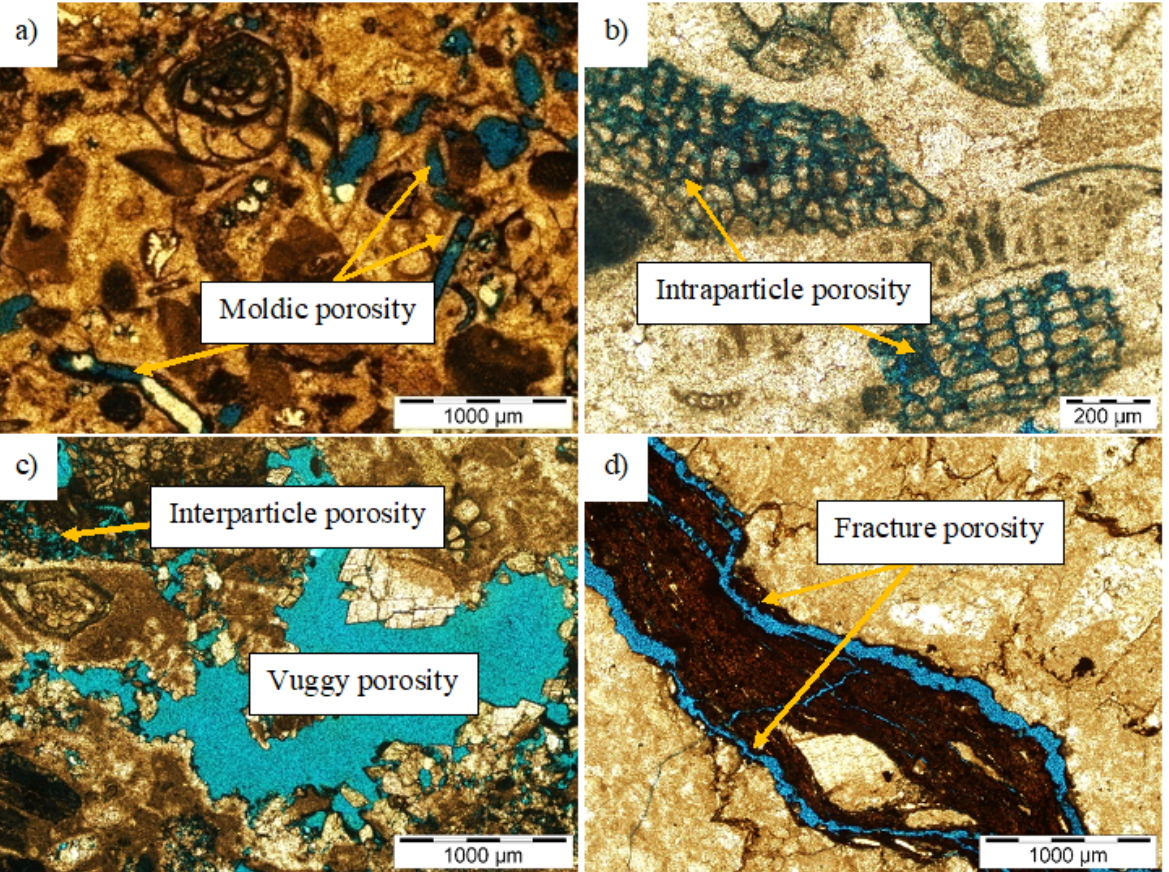
Figure 9. Photograph representing the different types of porosity ( a ) Intraparticle and mouldic porosity, ( b ) Fracture porosity, ( c ) Vuggy porosity and ( d ) Interparticle porosity and partial filling of dolomite, dolomite cement filling pore spaces and the rate of dolomitization increases with the time in Central Luconia, offshore Sarawak, Malaysia.